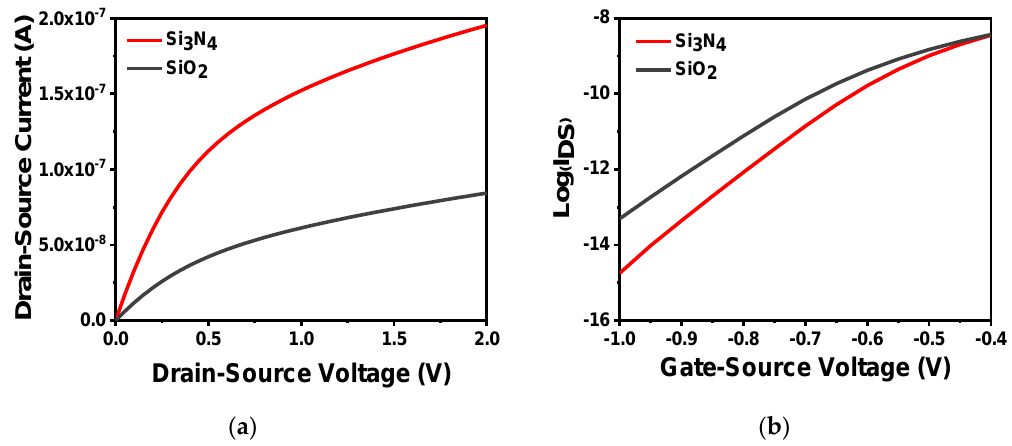
Figure 3. Characteristics of different gate dielectric materials: ( a ) output characteristic curve of different gate dielectric materials in 𝑉 𝐺𝑆 = 0.5 V; ( b ) different gate dielectric materials semilogarithmic curve of drain current versus gate voltage at 𝑉 𝐷𝑆 = 2.5 V .